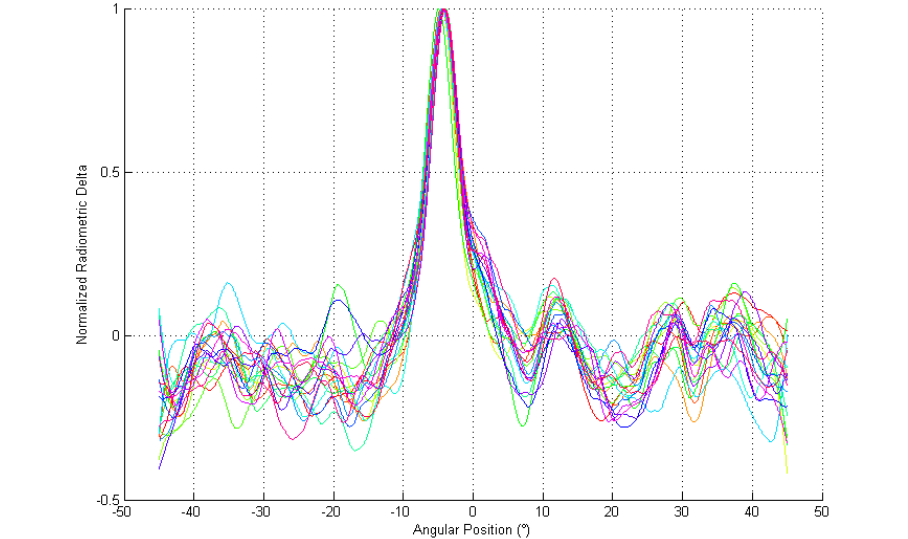
Figure 17. Human target radiometric pulses during repeated search phase (superimposed traces).